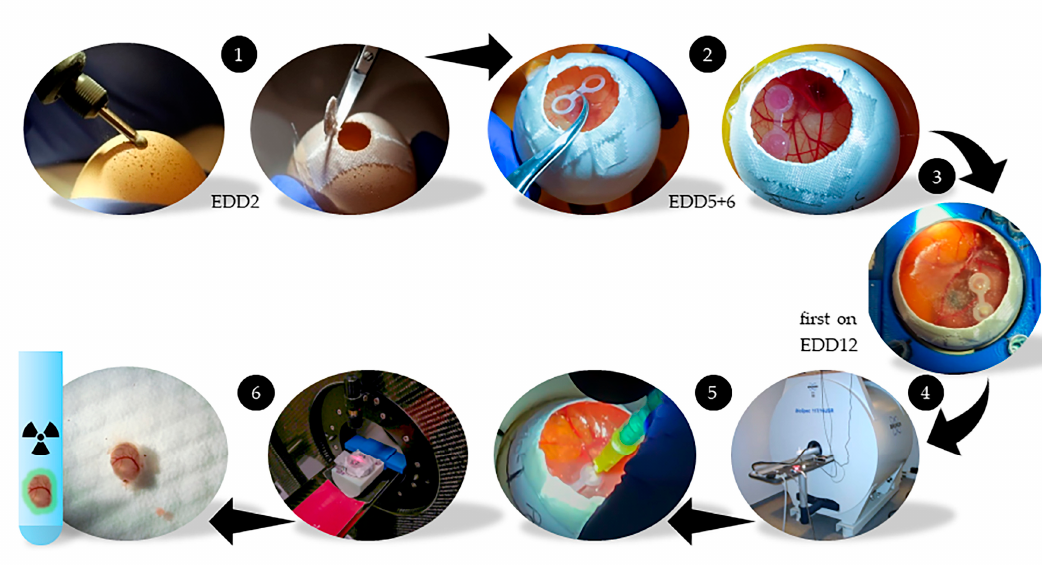
Figure 6. Workflow of the HET-CAM xenograft model. On the arrival day (EDD0) the eggs were incubated. On EDD2 the eggs were carefully opened ( 1 ). On days EDD5 and EDD6 the silicone rings were positioned, and the tumor cells were applied ( 2 ). The development of the tumors and the chick embryos was regularly checked ( 3 ). Between EDD12 and EDD16 three to five measurements per day were performed. Experiments started with high-resolution MRI ( 4 ). Immediately afterwards the ligand was systemically administered into a blood vessel of the CAM and the corresponding PET scan was performed ( 5 ). After PET the tumors were carefully excised, washed and the accumulated radioactivity was detected in a gamma counter ( 6 ). The embryos would not recover from the tumor excision and were sacrificed immediately.